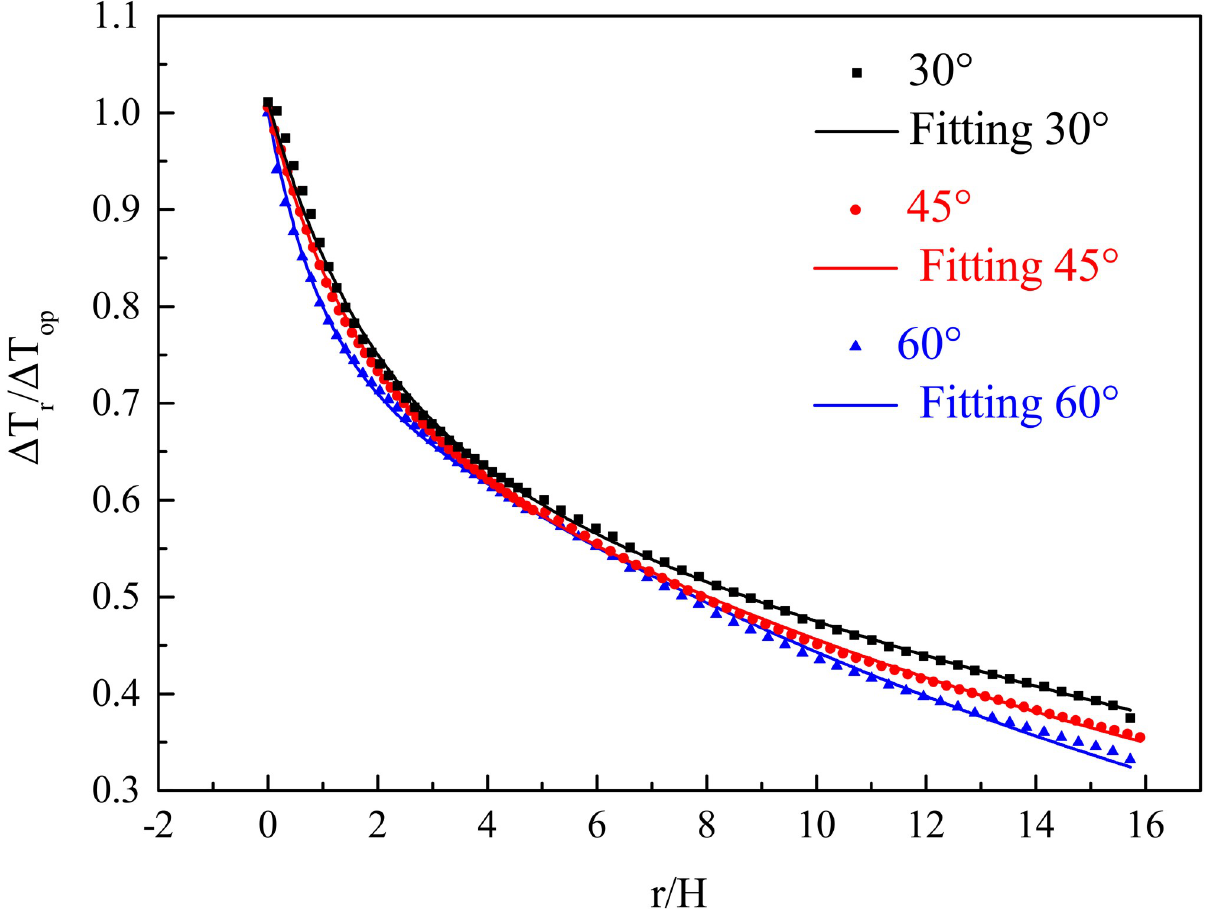
Fig 11. Dimensionless temperature rise ( Δ T r / Δ T of 5 MW.